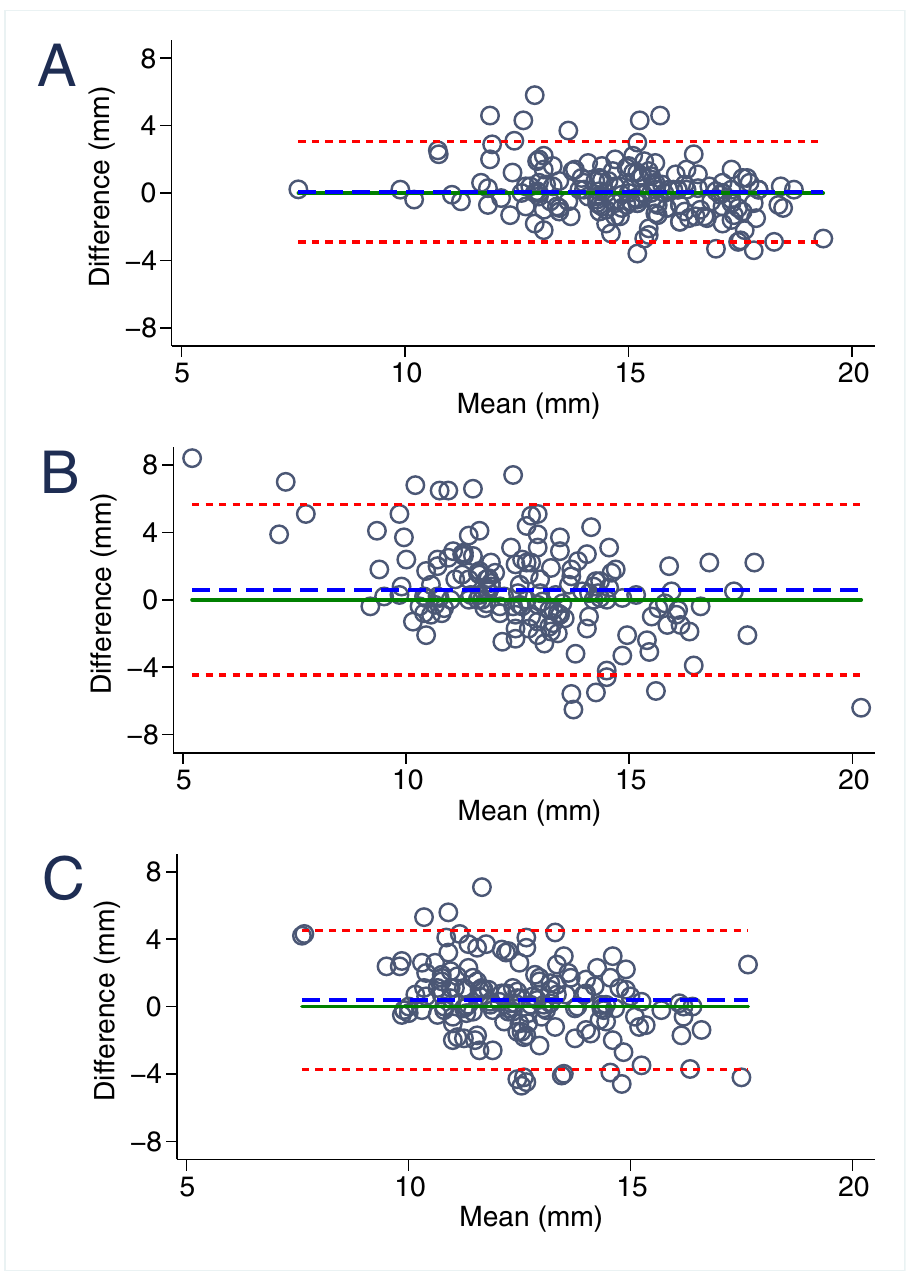
Fig 3. Bland-Altmann graphic: Reproducibility of MAPSE imaging. A. Intraobserver variability for m-mode derived MAPSE, B. Intraobserver variability for B-Mode lateral derived MAPSE, C. Intraobserver variability for B-Mode septal derived